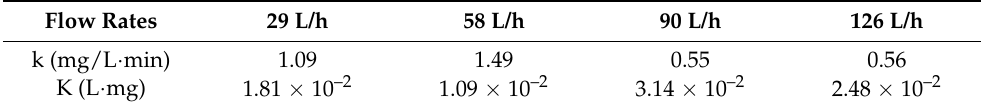
Table 1. Values of k(mg/L · min) and K (L · mg) for different flow